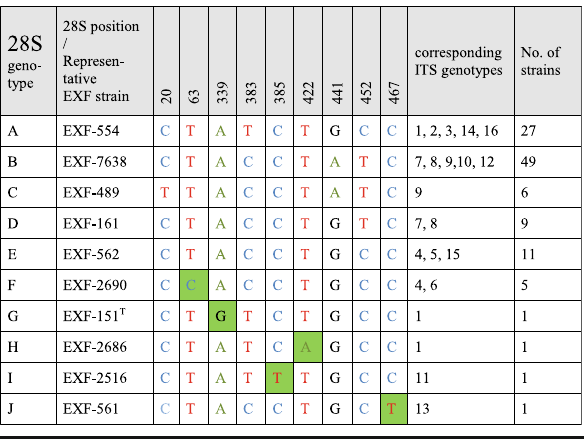
Legend: Green marked nucleotides represent nucleotide change in a single group or